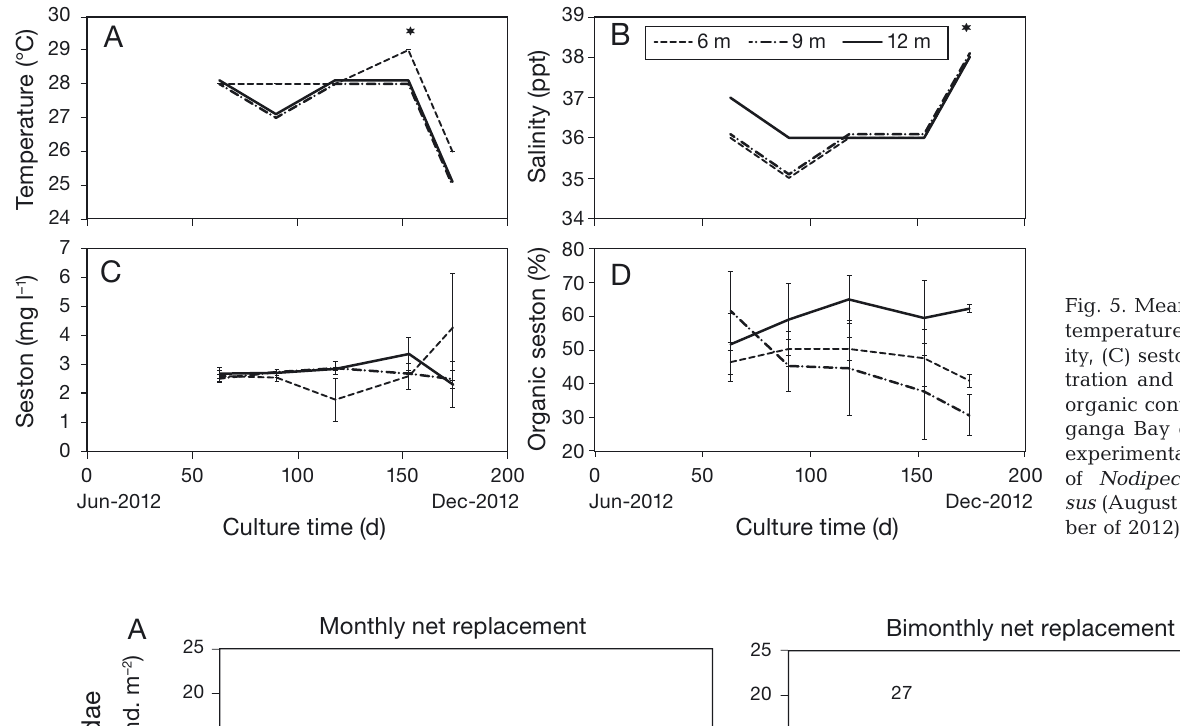
Fig. 5. Mean ± SE (A) temperature, (B) salin- ity, (C) seston concen- tration and (D) seston organic content in Ta - gan ga Bay during the experimental culture of Nodipecten nodo - sus (August to Decem- ber of 2012). *p < 0.05